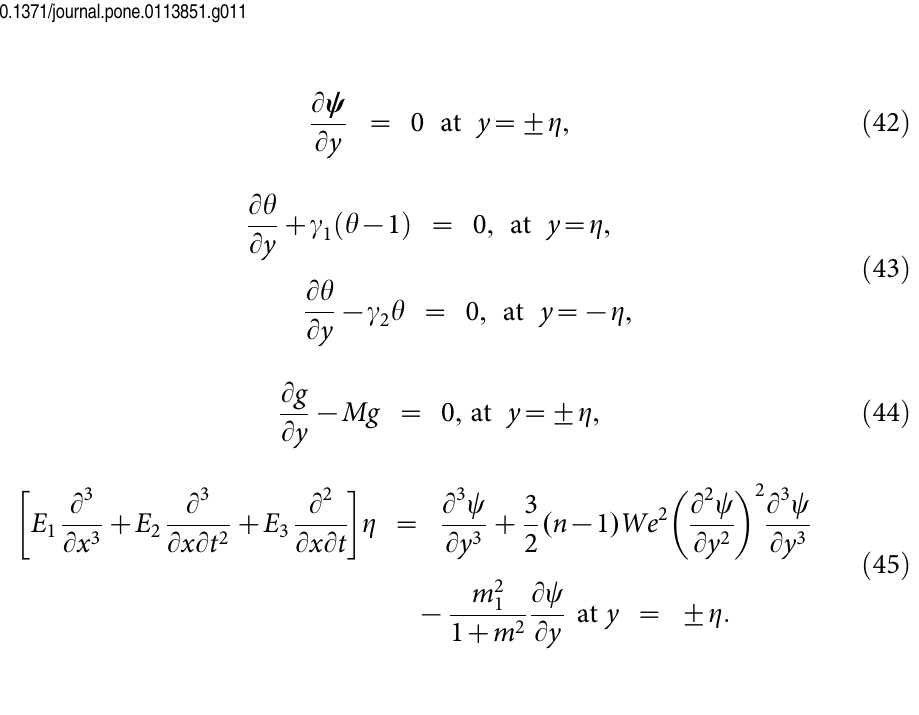
Figure 11. Plot of heat transfer coefficient Z for Biot number ª 1 with E ~ 0 : 1 , t ~ 0 : 01 , Br ~ 1 , ª 2 ~ 6 , E 1 ~ 0 : 4 ,